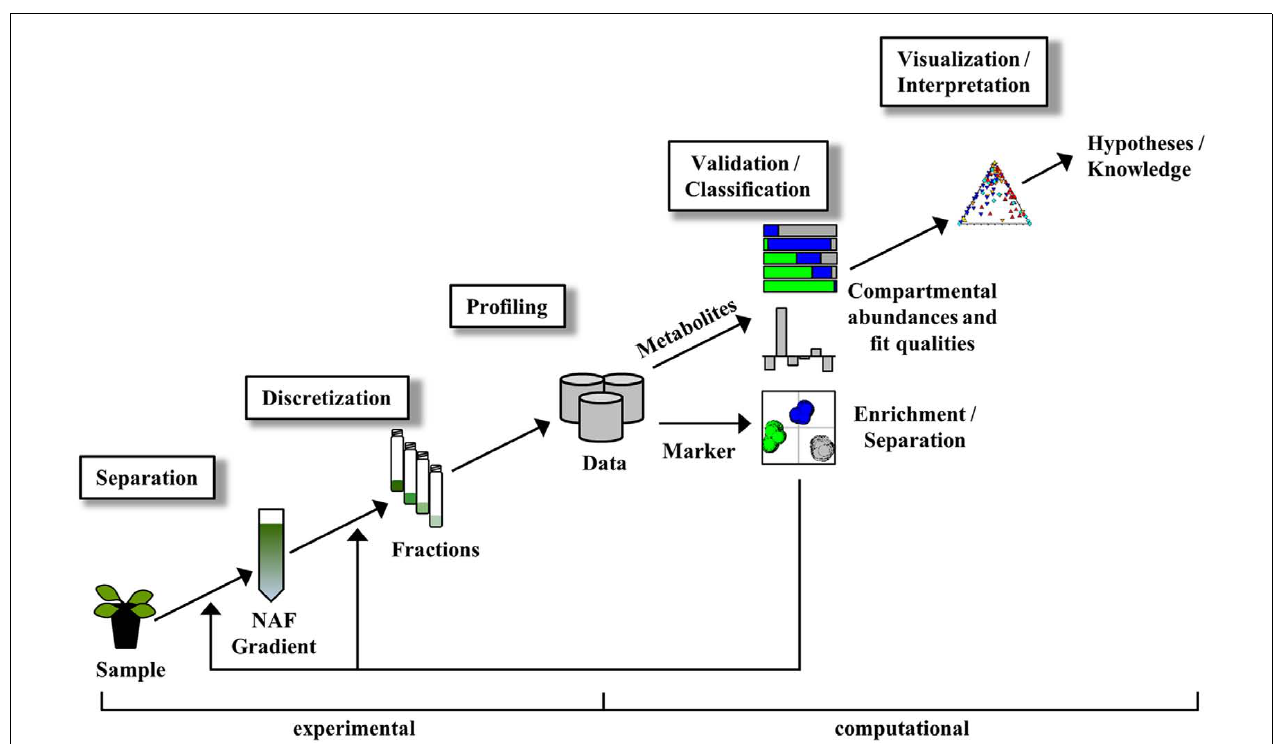
FIGURE 1 | Simplified scheme of non-aqueous fractionation procedure and associated data analysis steps. For details see manuscript